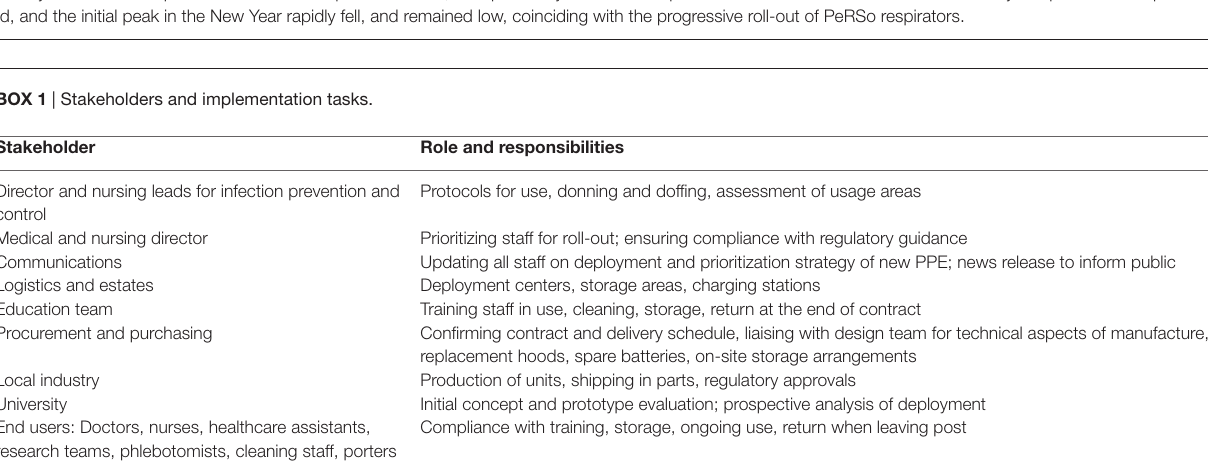
FIGURE 4 | Staff absence rates due to COVID19 were lower in Southampton than equivalent large UK teaching hospitals. Average daily absence rates per 1,000 clinically active staff are presented for the first quarter of 2021, as reported by individual hospital trusts to the national database. University Hospital Southampton is red, and the initial peak in the New Year rapidly fell, and remained low, coinciding with the progressive roll-out of PeRSo respirators.